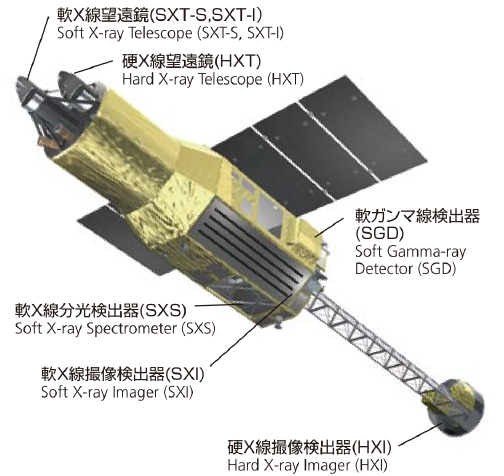
Figure 8. Diagram of the JAXA ASTRO-H X-ray astronomy satellite in its configuration before an on orbit fragmentation event. Figure adapted from JAXA [47], Courtesy of JAXA, c (cid:13) JAXA.